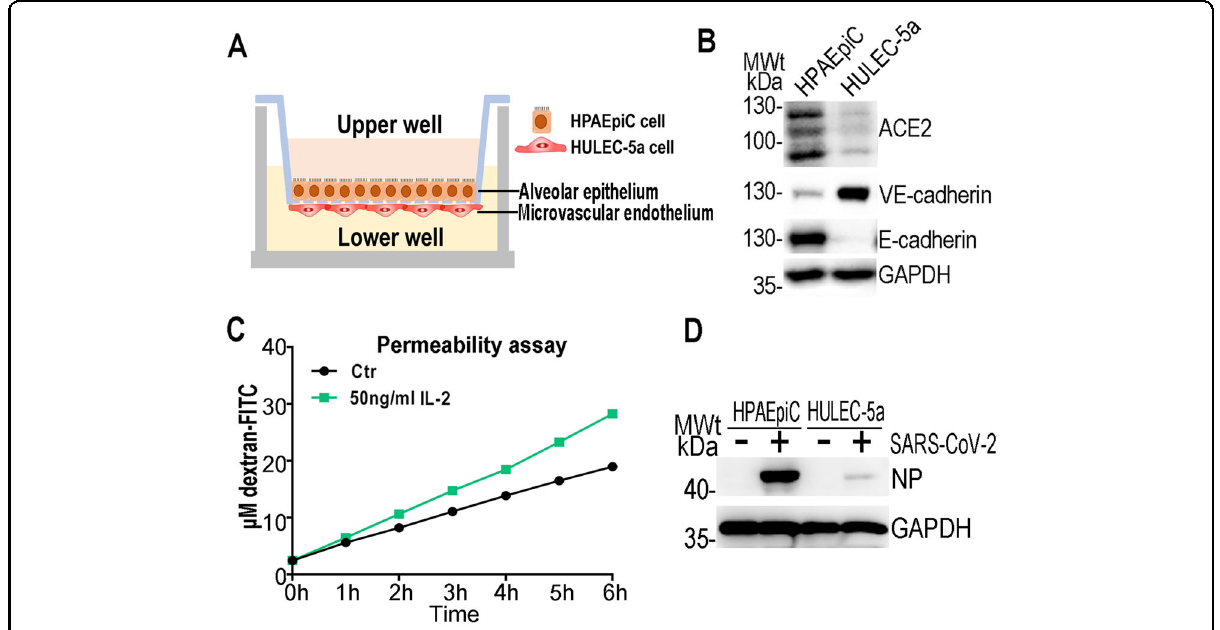
Fig. 4 SARS-CoV-2 infection in an alveolar epithelium/endothelium co-culture system based on transwell. a A schematic diagram for an alveolar epithelium/endothelium co-culture system based on a transwell chamber. b Western blot was performed to analyze the levels of ACE2, E-cadherin (epithelial cell marker), and VE-cadherin (vascular endothelial cell marker) for HPAEpiC cells and HULEC-5a cells collected from the co- culture system, separately. c Blood-to-alveolus permeability assay of dextran-FITC (10 kDa) was measured on the co-culture system to evaluate the integrity of the alveolar – capillary barrier. Data were presented as mean ± SEM, n = 3. Data were analyzed by Student ’ s t test (***: P < 0.001). d Western blot was performed to analyze the viral Nucleoprotein (NP) level of HPAEpiC cells and HULEC-5a cells collected from the co-culture system separately following SARS-CoV-2 infection. b , d These results are representative blots from three independent